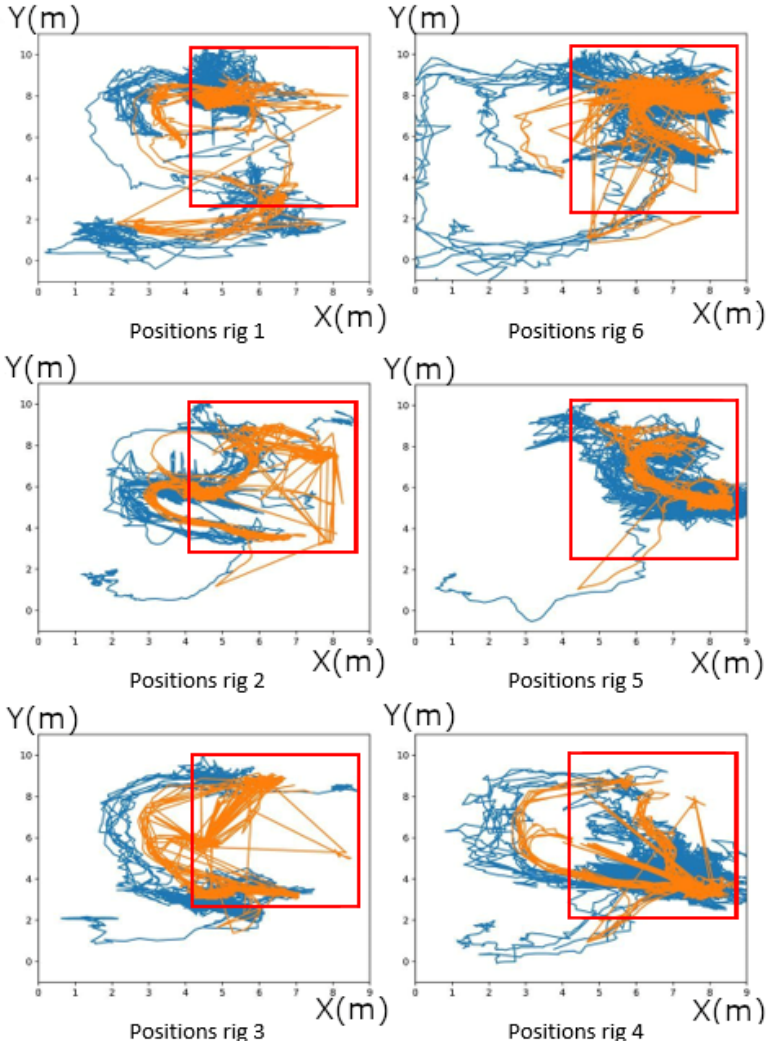
Figure 5. Movement of each person according to their rig in meters made in a workshop. Motion capture system is in orange and UWB system is in blue. Red square is the area of the working